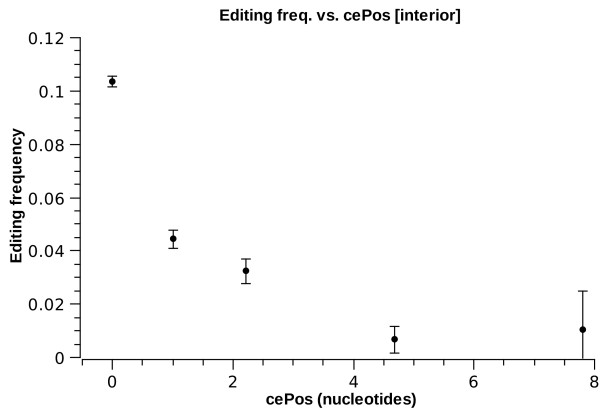
E1 frequency vs. cePos for interior loops.